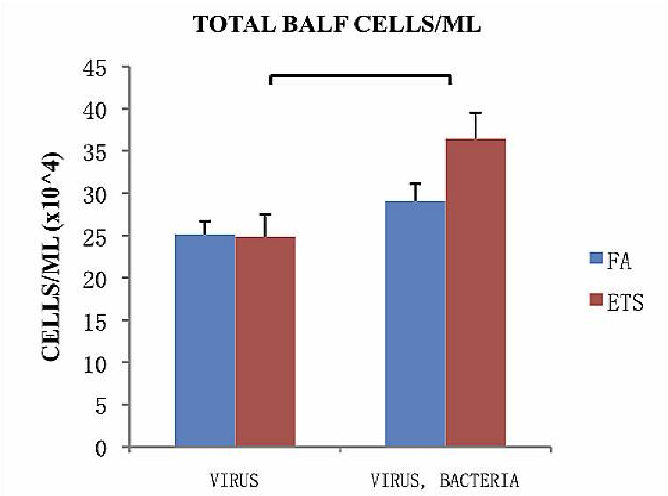
Figure 4. Total cells/mL collected from BALF 24-h post-bacterial infection. Virus groups had the same amount of cells 8 days following viral inoculation, while groups treated with both virus and bacteria showed an increase in the number of cells 8 days following viral inoculation and 1 day post bacterial infection. Data is presented as the group mean (n = 10) ±SEM. The bracket between bars designates a statistically significant difference between the ETS-virus and ETS-virus-bacteria groups ( p <